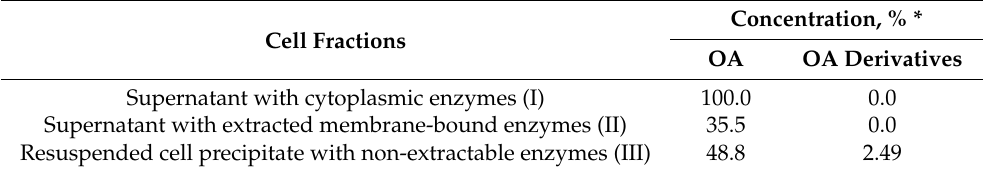
Table 4. Composition of extracts obtained after OA biotransformation by individual cell